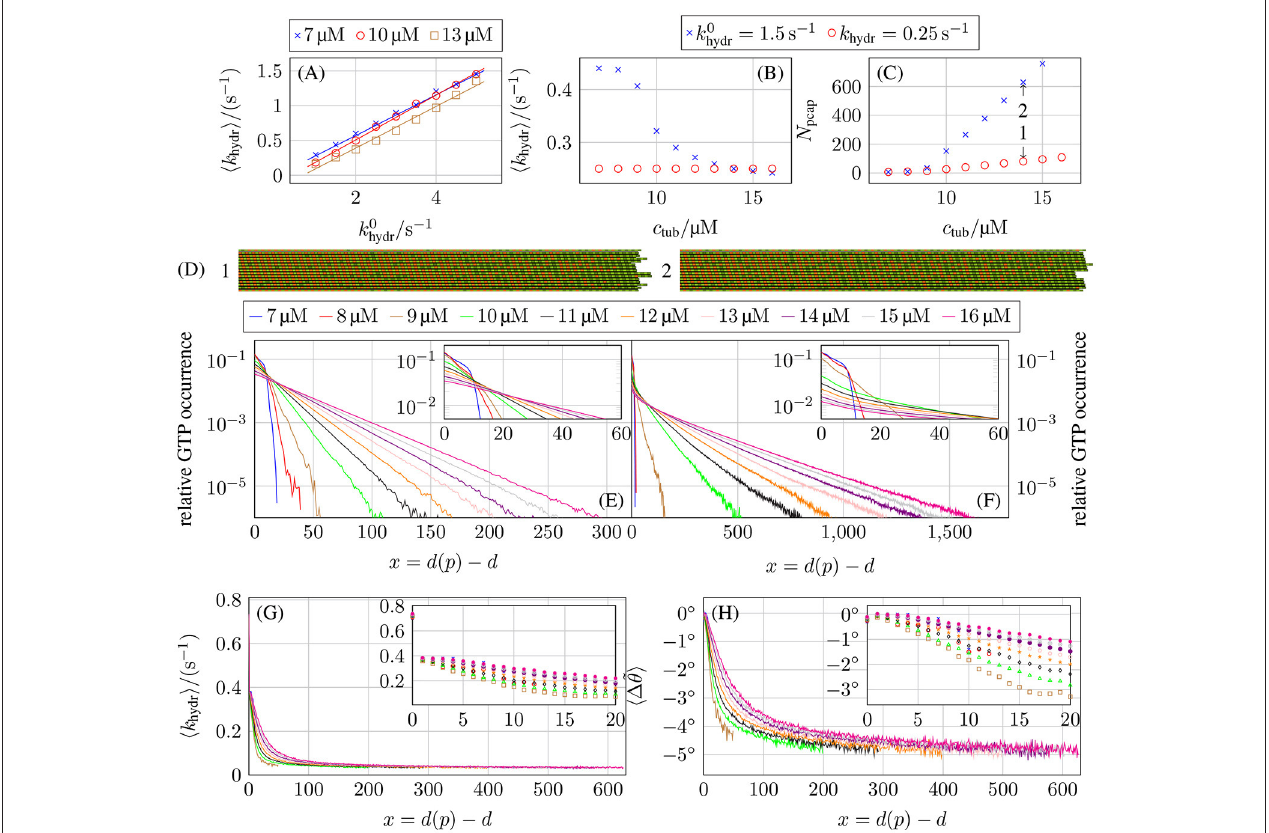
FIGURE 11 | (A) Average actual hydrolysis rate h k hydr i as a function of the constant base hydrolysis rate k 0 hydr . Comparison of (B) the average actual hydrolysis rate h k hydr i and (C) the porous cap length N pcap as a function of the free tubulin dimer concentration c tub for hydrolysis coupled to mechanics with k 0 constant hydrolysis rate of k hydr = 0.25s − 1 . (D) Shows the two-dimensional representations of two MT tip configurations that are marked by arrows in (C) at t sim = 5min. The top and bottom protofilaments are periodic images of p = 13 and p = 1, respectively. Relative occurrence of GTP-tubulin dimers as a function of the dimer-based distance from the protofilament tip d ( p ) − d for (E) a constant hydrolysis rate of k hydr = 0.25s − 1 and (F) hydrolysis being coupled to mechanics and k 0 hydr = 1.5s − 1 . (G) Average hydrolysis rate as a function of distance d ( p ) − d from the tip and (H) the associated average bending angle h 1 ˜ θ i for hydrolysis coupled to mechanics and k 0 hydr = 1.5s − 1 . All plots are for k + = 4 µ M − 1 s − 1 , 1 G 0 ∗ long = − 9.3 k B T , and k lat = 100 k B T / nm 2